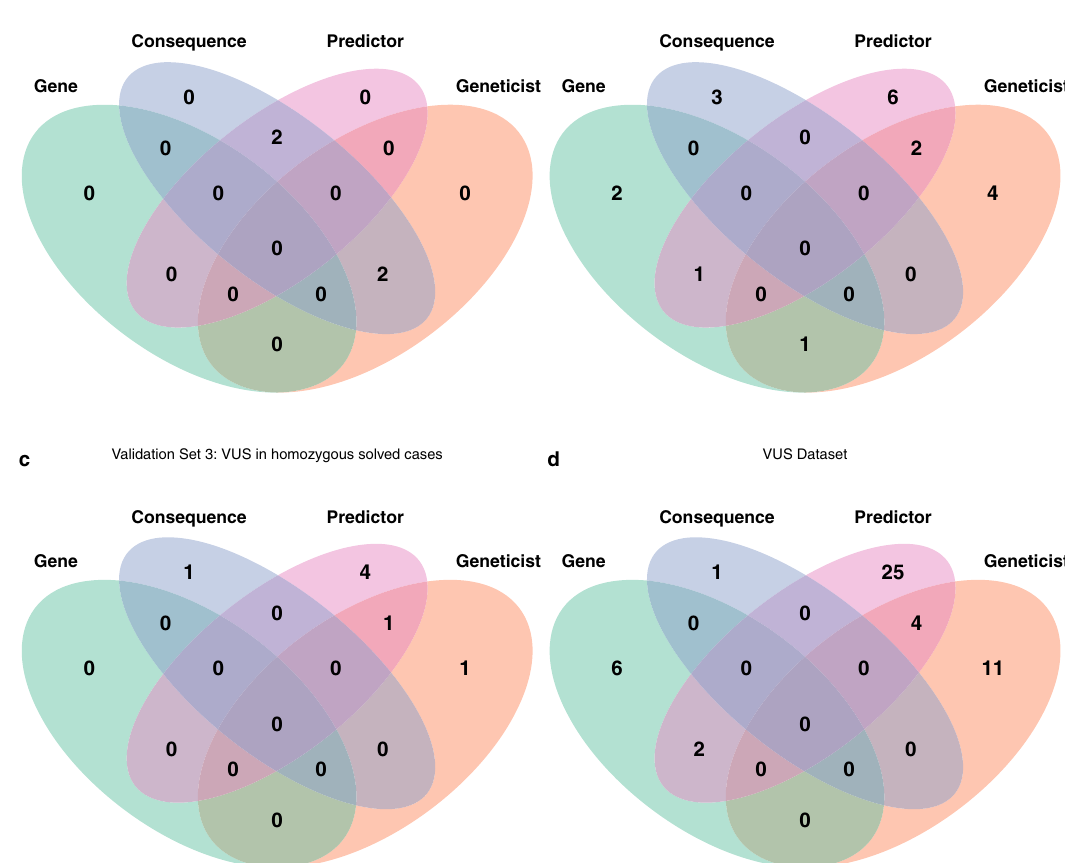
Fig. 5 Rule-based algorithm. Applied to VUS reclassi fi ed as pathogenic/likely pathogenic dataset ( a ), VUS in recessive solved cases ( b ), VUS in homozygous solved cases ( c ), and applied to VUS dataset ( d